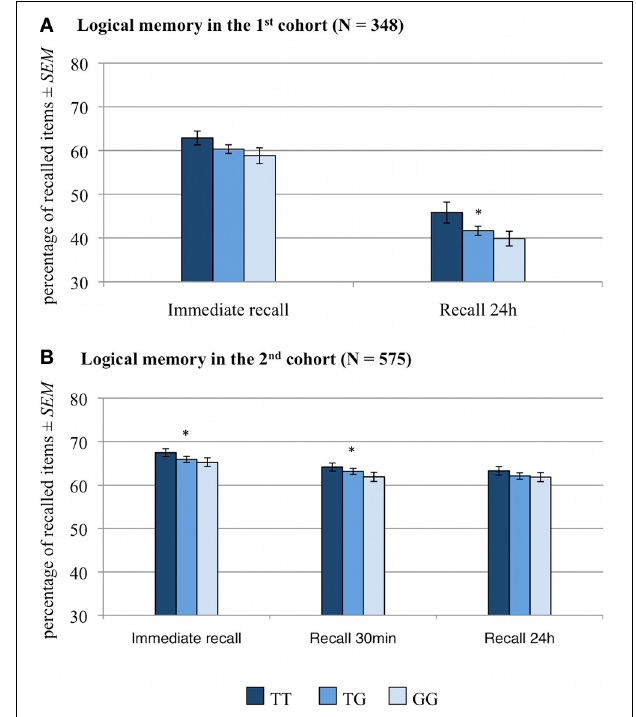
FIGURE 2 | Memory effect of RASGRF1 in a logical memory task WMS). Higher % values indicate better memory performance. (A) In the first cohort correlation analyses revealed a significant correlation between the T allele count and performance in the 24-h delayed recall test and a trend-wise positive correlation between T allele count and immediate recall performance. (B) In the second cohort, T allele count was positively correlated with performance in the immediate recall test and in delayed recall after 30min. *Significant at p < 0 . 05. third (Spearman’s ρ = 0 . 15, p = 0 . 008) learning trials, but